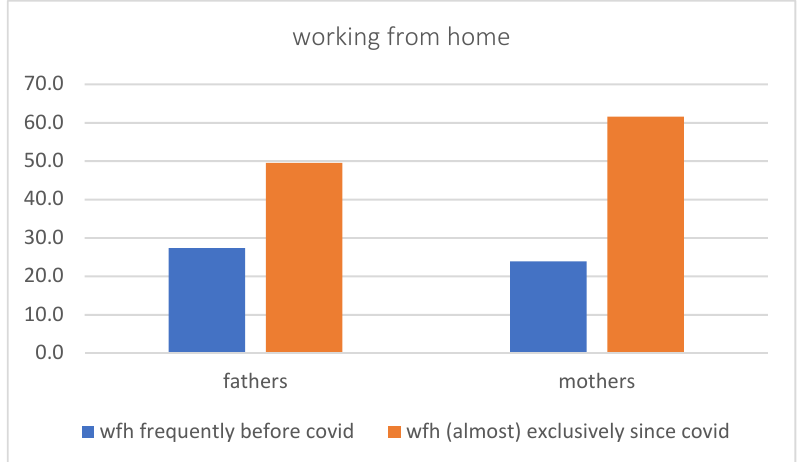
Figure 1. Men and Women working from home before and during the COVID-19 lockdown in percentages. WHF frequently refers to working from home at least once a week; WFH (almost) exclusively refers to working from home at least 3 days a week.